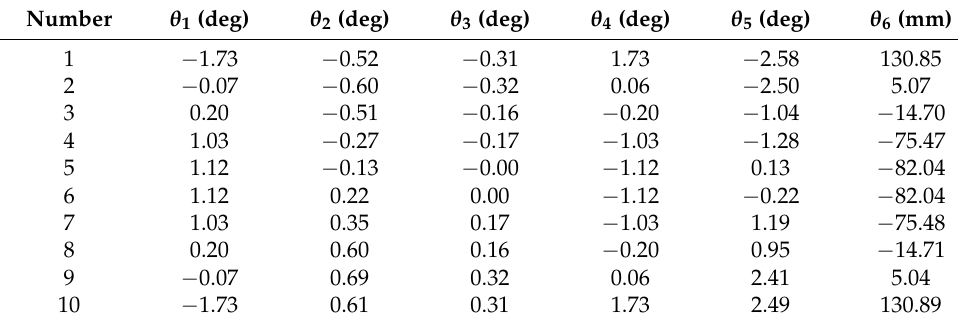
Table 3. The motion of joints on the left side of the vehicle’s secondary